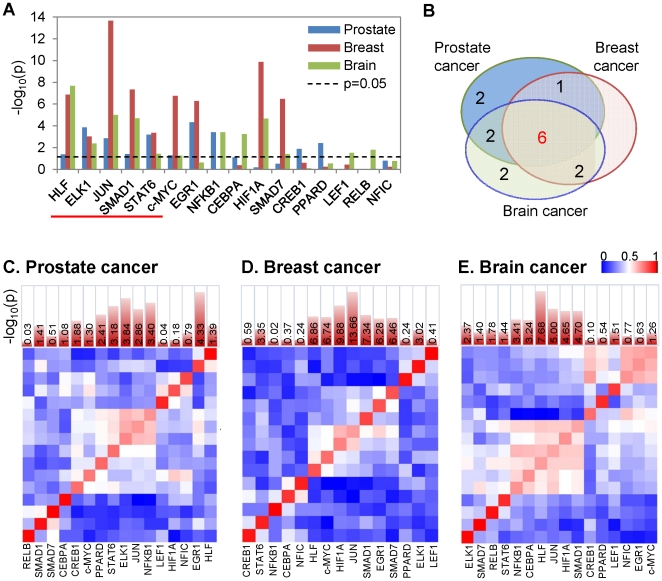
Subsets of PTEN-controlled TFAs preferentially function in specific types of tumors.(A) t-test p-values comparing TFAs of the subgroups based on PTEN status and clustering results as shown in Figure 5 in three tumor types. In the t-tests performed on of prostate and breast cancers, PTEN positive samples in group 3 were used as the PTEN positive functional status, the PTEN negative samples in group 1 as the PTEN negative functional status. Similarly, in brain tumor PTEN IHC positive samples in group 2 and PTEN IHC negative samples in group 1 were selected for representing PTEN positive and negative functional status respectively. The red line highlighted the 6 TFAs significantly (p<0.05) altered between tumor subgroups in three tumor types. (B) Venn diagram summarizing the overlap of the TFAs that contribute to the discrimination of tumor subgroups with different PTEN status in different tumor types. (C–D) Heatmap of the absolute Pearson correlation coefficients between NCA-inferred TF activity profiles across the tumor samples from prostate (C), breast (D) and brain (E) cancers, indicating groups of co-active transcription factors may function together.